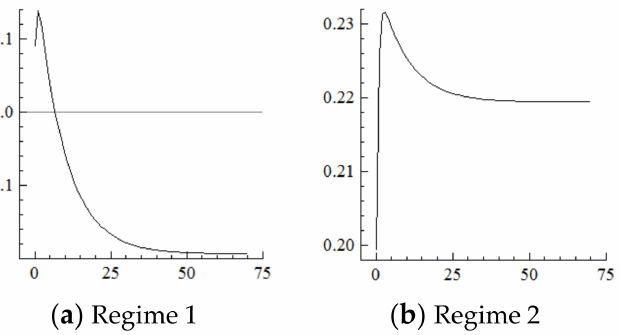
Figure 8. Cumulative Impulse Response of Industrial structure upgrading to Technological